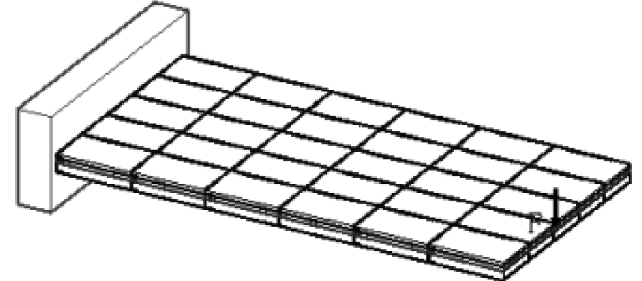
Fig. 4. A cantilever plate/CLD